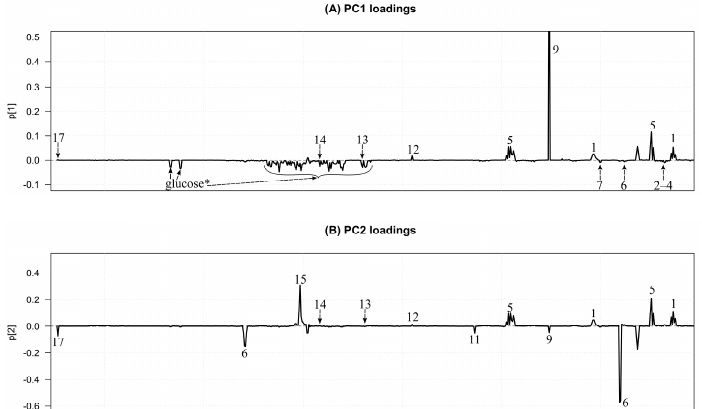
Figure A2. Loading plots of the PCA model of the full S. aureus sample set: ( A ) PC1 and ( B ) PC2 loadings with the x-axis reversed to mimic the chemical shift axis of a 1 H NMR spectrum. Significant metabolites and their labels are presented in Table 1.